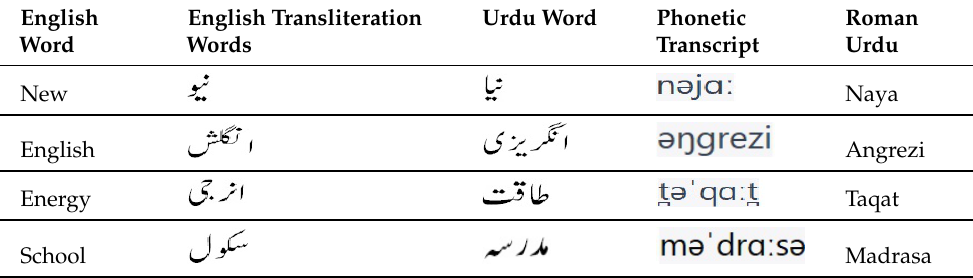
Table 1. Example English Transliteration Words in Urdu Script.